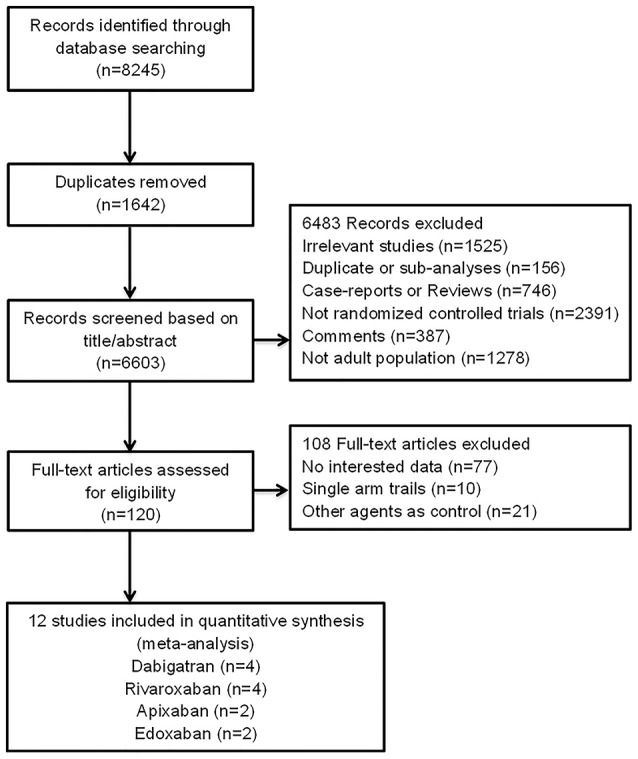
Flow diagram for the selection of eligible randomized controlled trials.